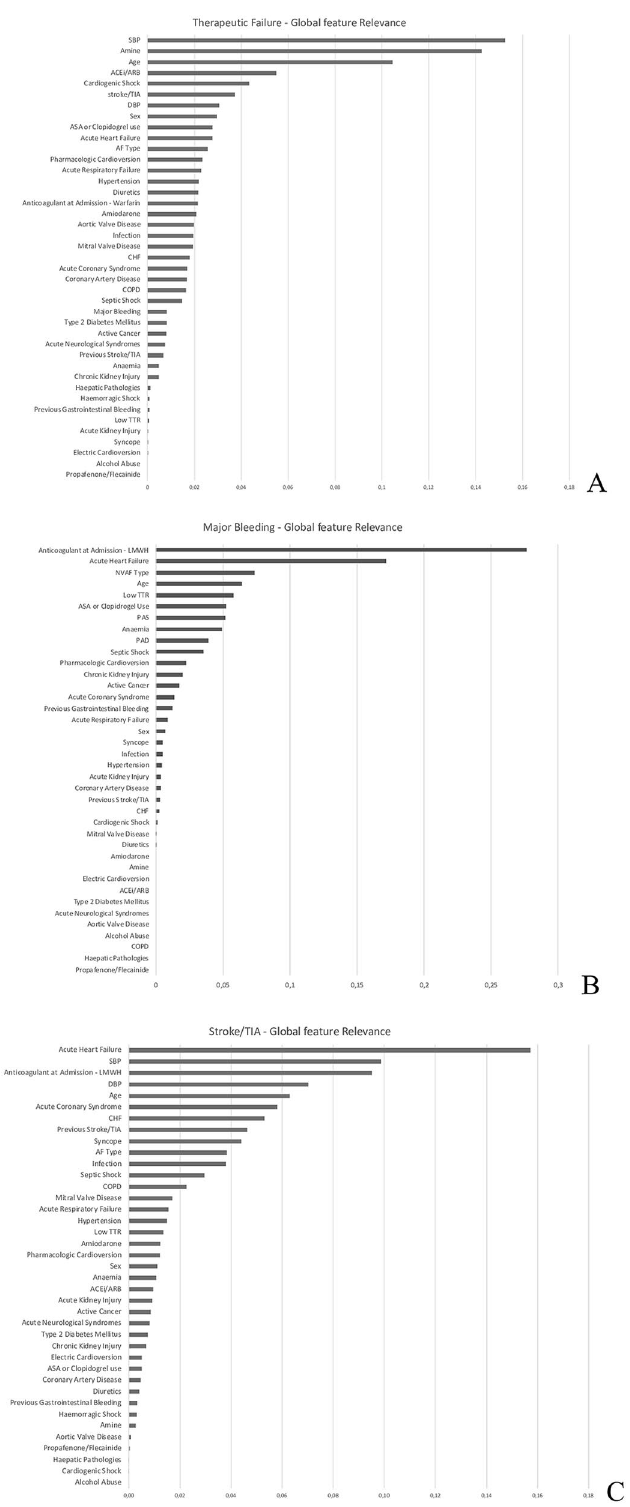
Figure 3. Skater results for ( A ) “therapeutic failure” ( B ) “major bleeding” ( C )